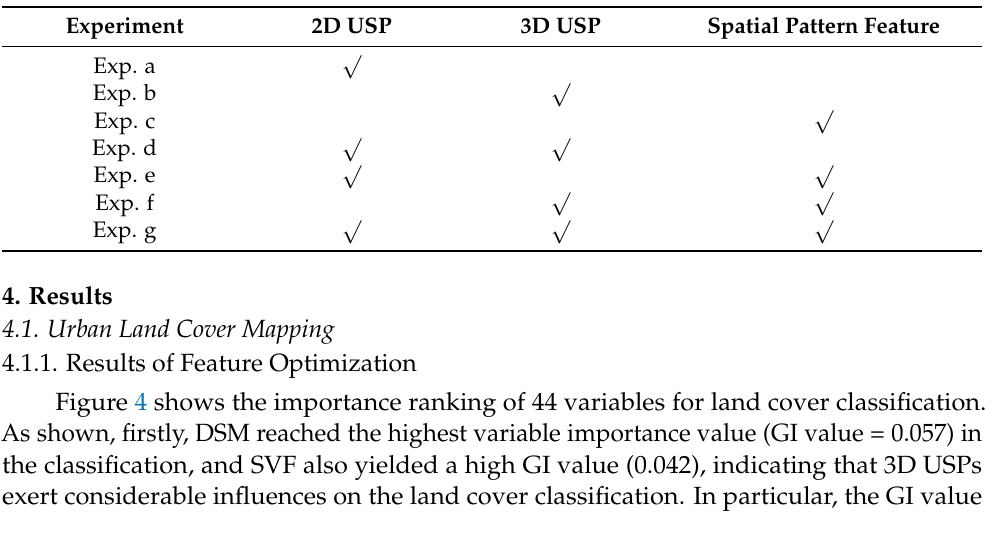
Table 5. Experiments used for UFZ